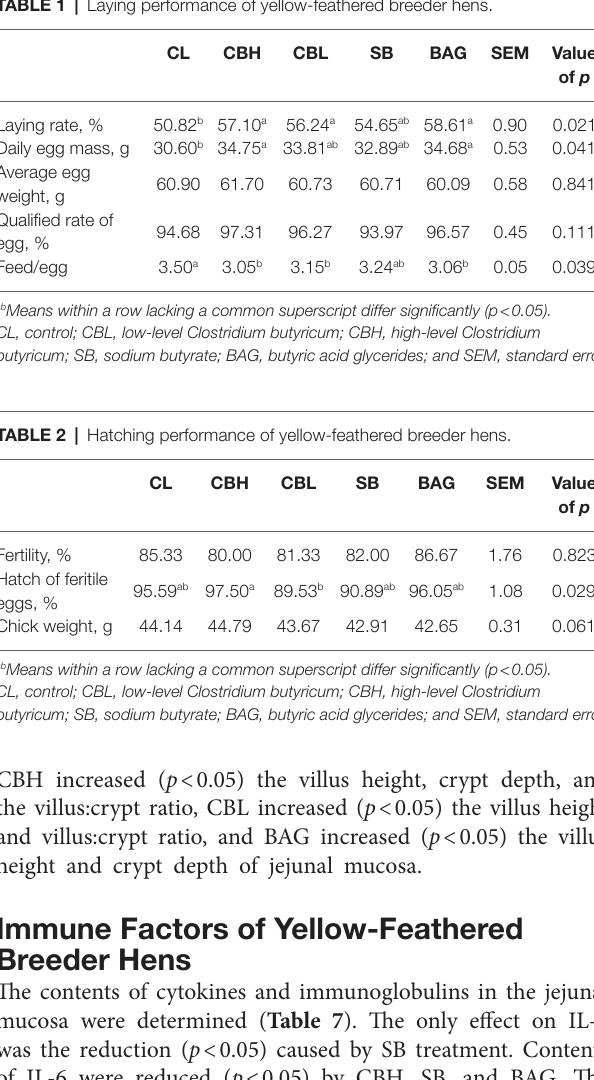
TABLE 1 | Laying performance of yellow-feathered breeder hens.